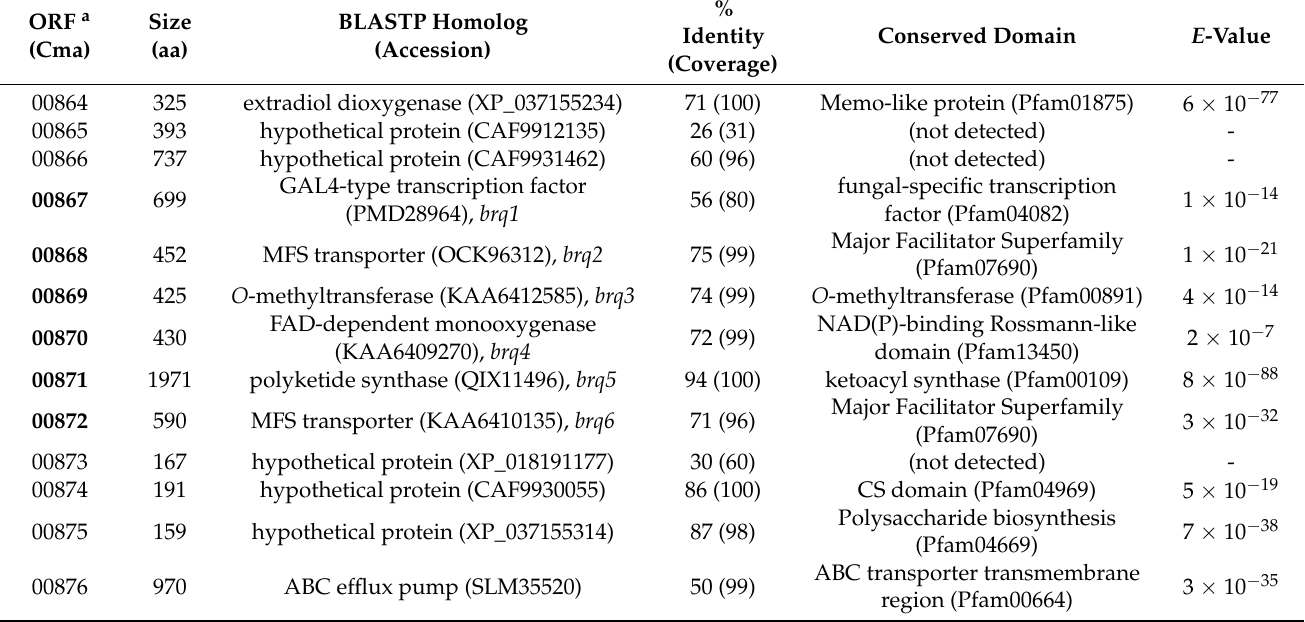
Table 1. The biruloquinone biosynthetic gene cluster in Cladonia macilenta